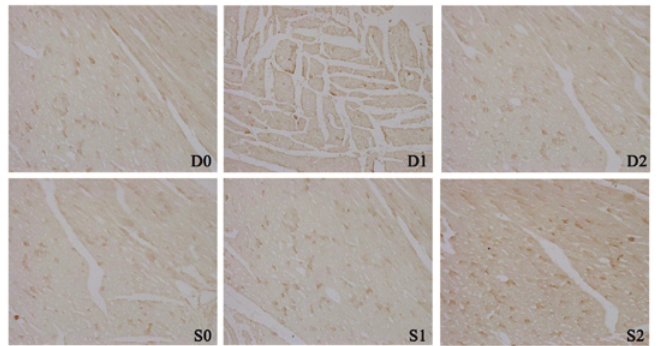
FIGURE 2 - IL-6 expression in the myocardium (200x). IL-6 expression in the myocardium increased in SHR over age (p<0.05: S0 vs S1; S0 vs S2). In the SHR undergoing RDN, the IL-6 expression was significantly lower than that in the rats of sham group (p<0.05: D1 vs S1; D2 vs S2).